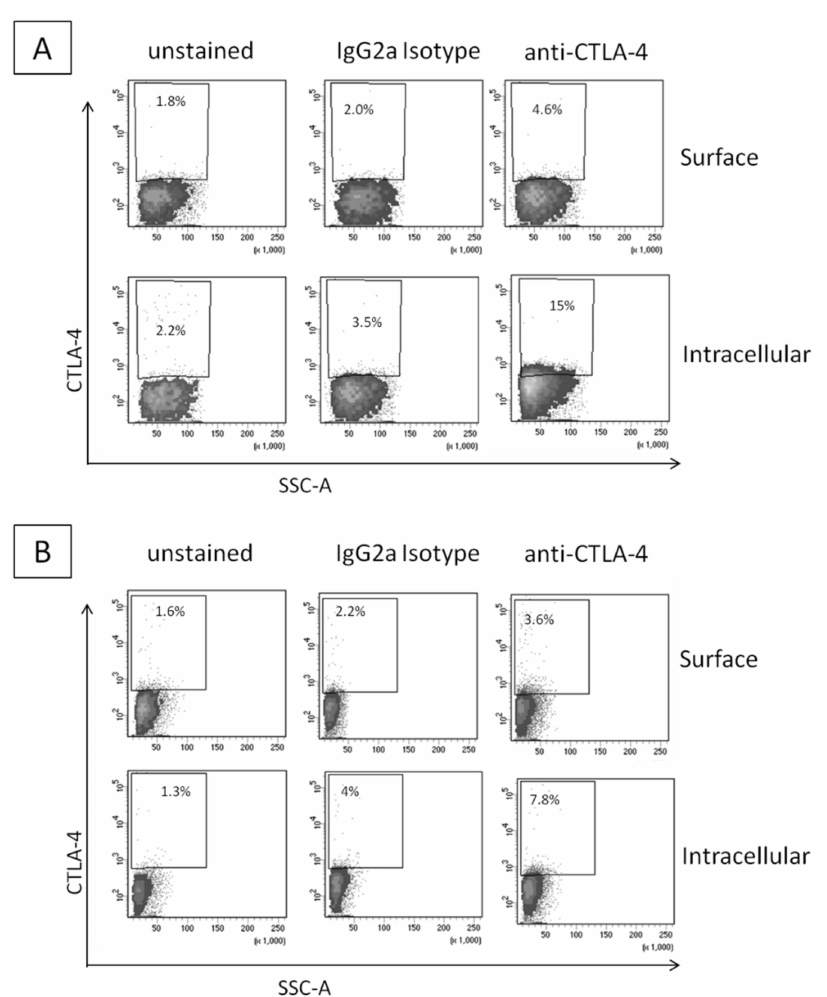
Figure 1. Flow-cytometric analysis of CTLA-4 in human breast cancer cells MDA-MB-231 ( A ) and MCF-7 ( B ). MDA-MB-231 and MCF-7 were stained on their surface or intracellularly with the designated antibodies. IgG2a Isotype corresponds to the staining with a negative class-matched control antibody. Results are expressed as percentage of stained